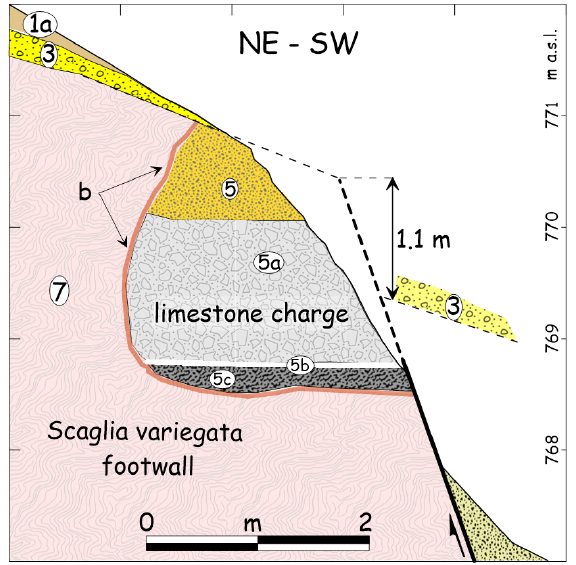
Figure 8. Schematic cross section of the faulted limekiln (legend same as Figure 7). In the hanging- wall, level 3 is projected in the plane-section in order to highlight its vertical offset (see Figure 7). The rear wall of the kiln (b) is